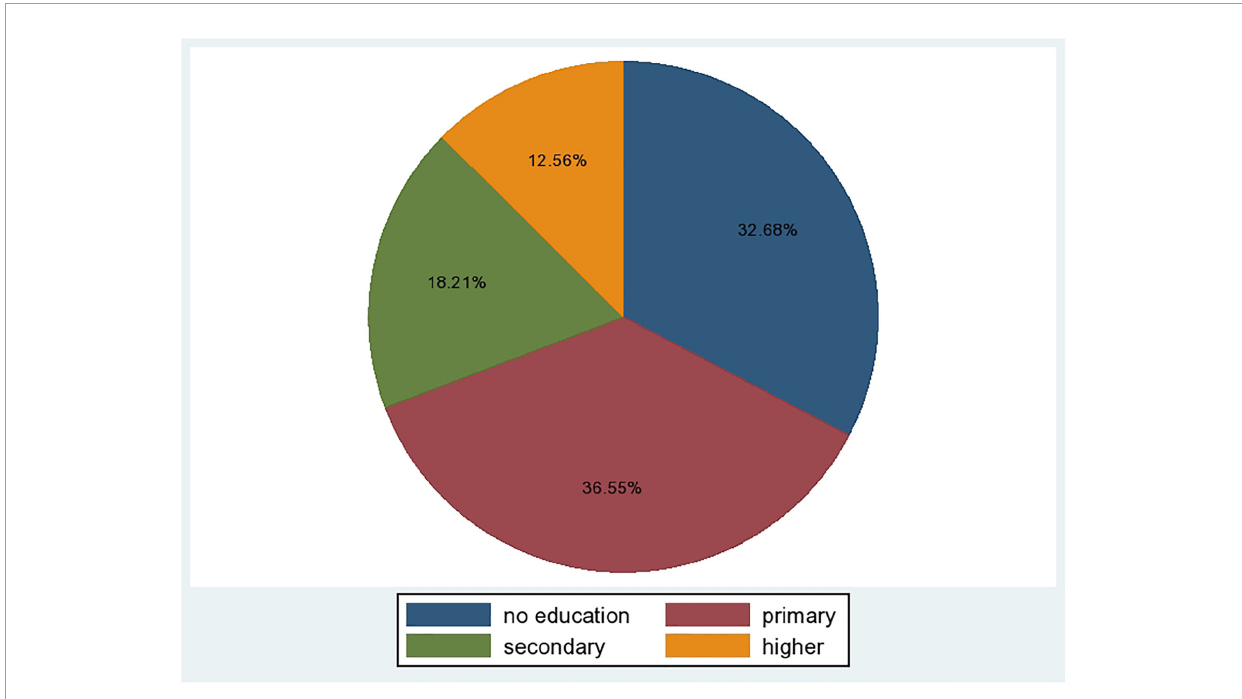
FIGURE1 Pre-martial HIV testing over the educational status of married reproductive aged women in Ethiopia.